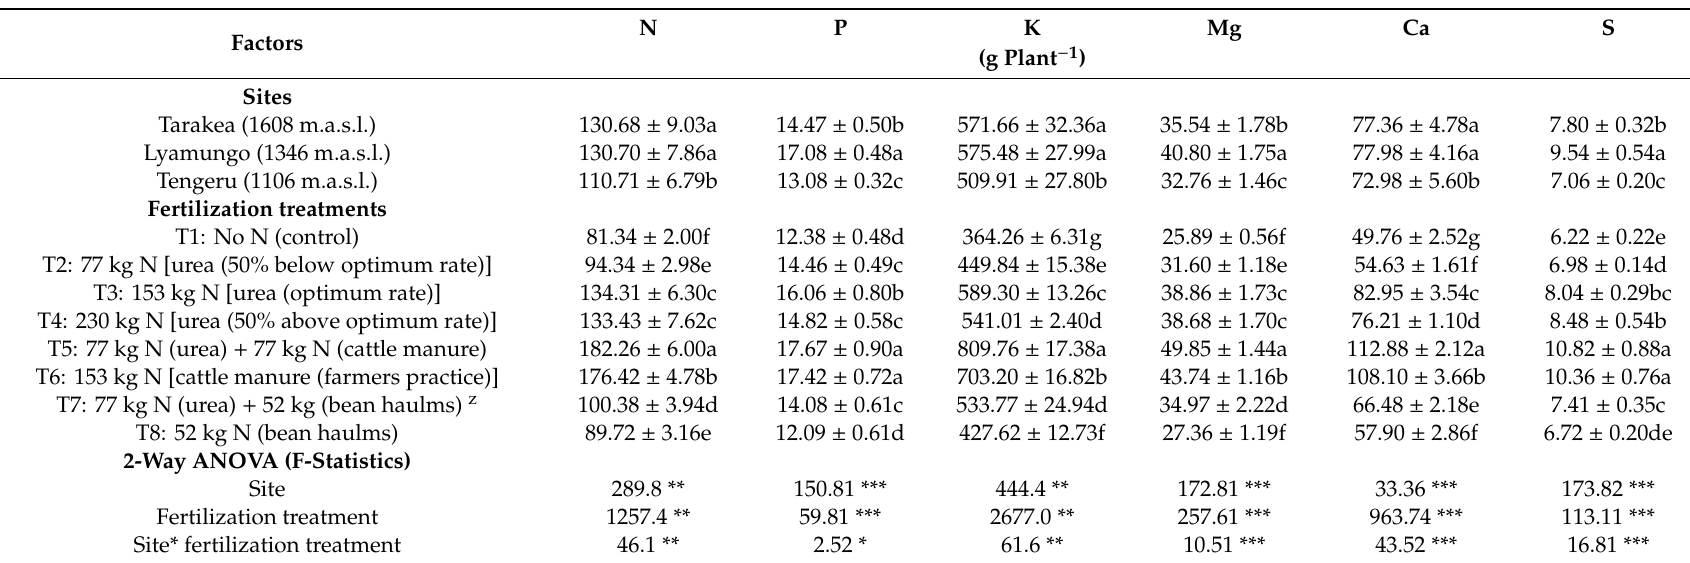
Table 6. E ff ects of fertilization treatments on total nutrient contents in the above ground biomass of Mchare banana at harvest at three sites located along the altitudinal gradients in volcanic soils of the northern highlands,